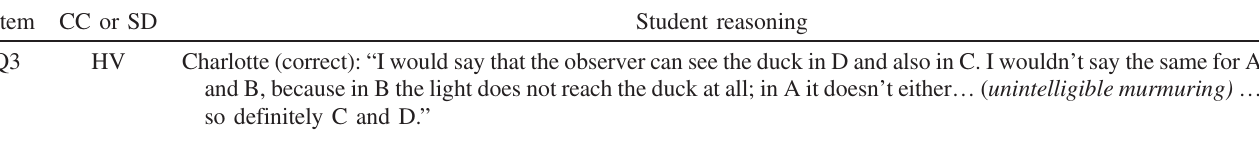
TABLE VII. Examples for students ’ reasoning about why they chose a specific answer option. “ CC or SD ” stands for “ core concept ” or “ student difficulty ” addressed in the student ’ s